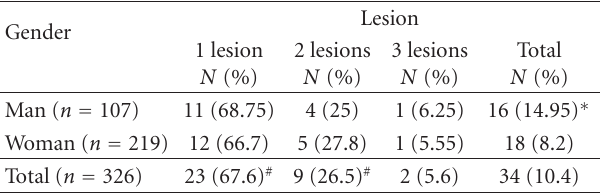
Table 3: Distribution of the lesions’ number according to the gen-